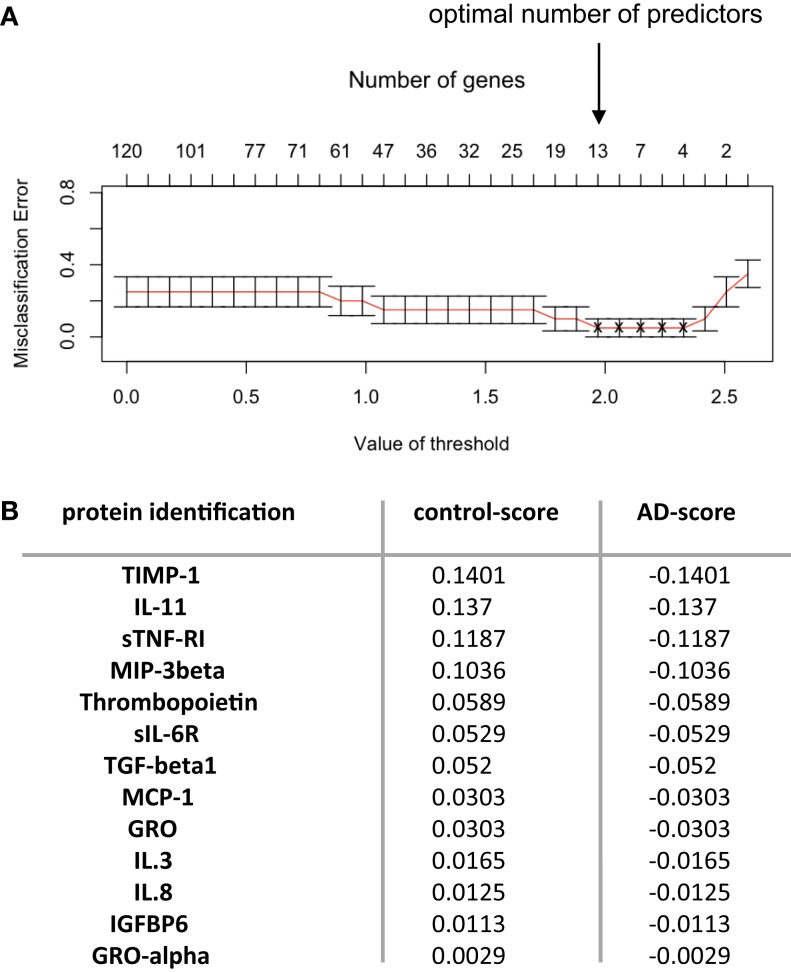
Predictors discovery. (A) Predictor discovery by prediction analysis for microarrays (PAM) was performed with normalized array measurements of 120 signaling proteins in the training set. Internal cross-validation (redline) decreasing the centroid threshold (lower x-axis) resulted in an increase in the number of markers (inserted upper x-axis) that were used for classification and calculation of the classification error (y-axis). This led to the discovery of an optimal set of 13 predictors with lowest possible classification error. (B) The 13 predictors identified through PAM analysis are presented. Proteins are arranged in columns, with d-score corresponding in each group. Control group corresponded to control subjects and MCI non-AD patients (groups A–C defined for protein-arrays analysis); AD group corresponded to AD late-stage patients and MCI presenting AD profile (groups B–D defined for protein-arrays analysis). Positive d-score is indicative of increased expression and negative d-score reflects decrease in the expression of the proteins analyzed.